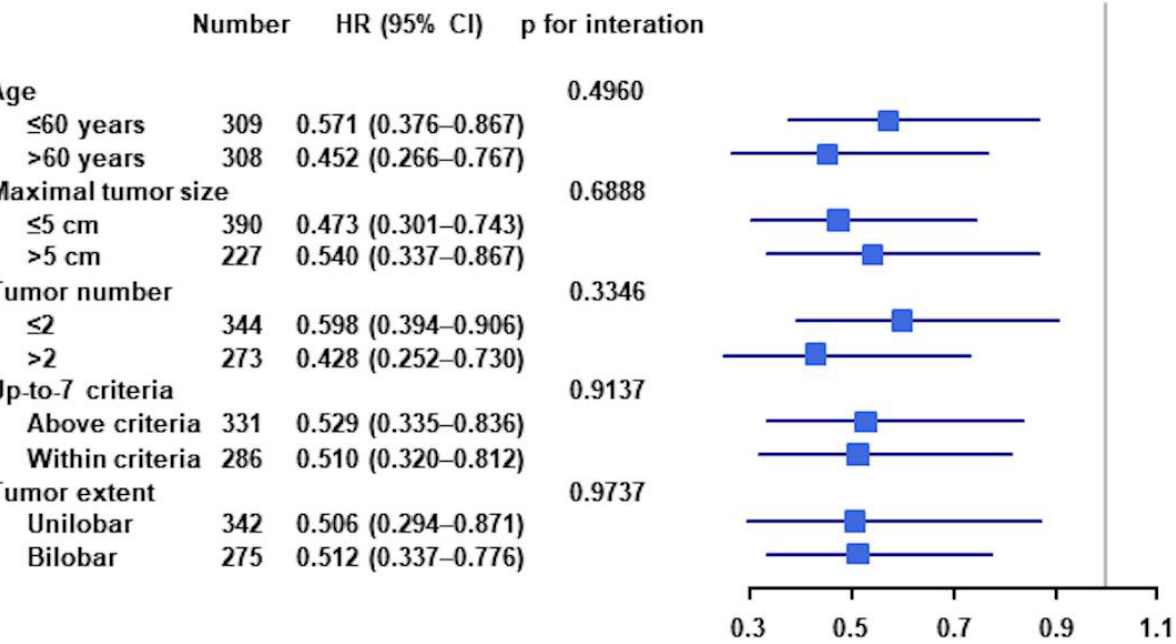
Figure 5. Subgroup analyses of overall survival (OS) in the entire study